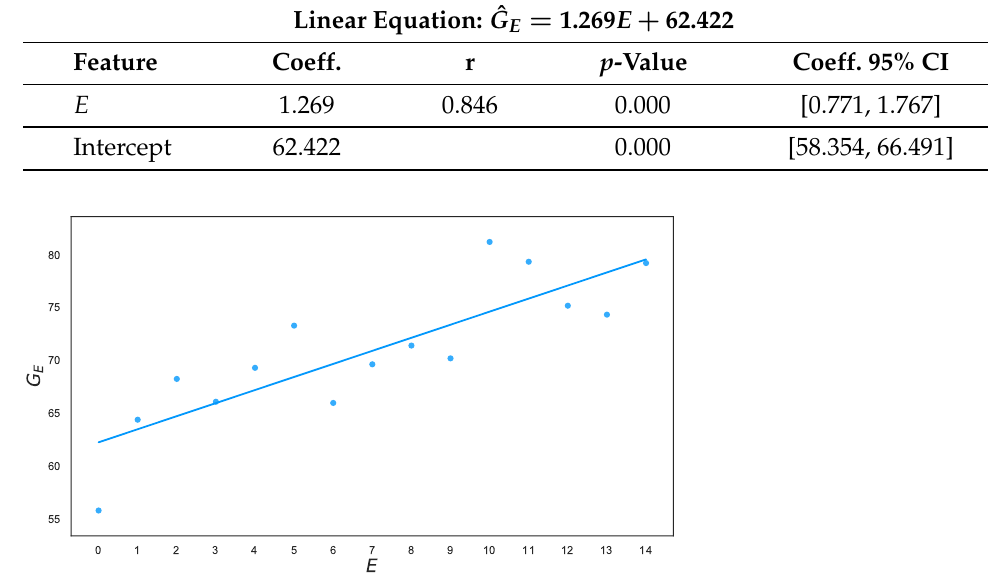
Figure 3. Extraversion-level Grade against Extraversion-level. r = 0.846, p = 0.000.